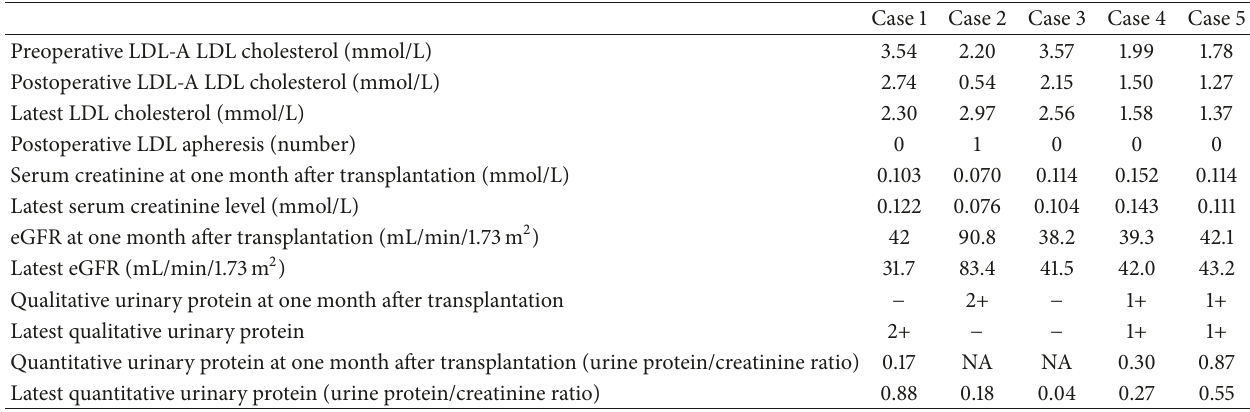
Table 2: Perioperative clinical